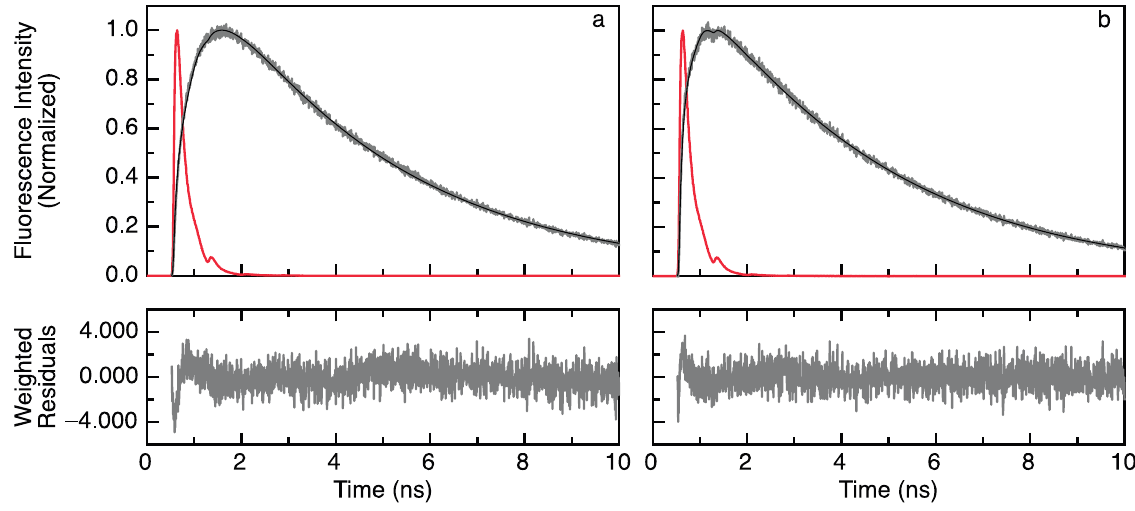
Figure 1. Fluorescence lifetimes with corresponding negative and positive amplitudes characterize the time-resolved fluorescence of the acceptor upon donor excitation. ( Top ) The time dependence of experimental (grey) and fitted (black) fluorescence intensity of apoflavodoxin labeled with A488 (donor) and A568 (acceptor) (see the Experimental Section for details on the theoretical background, protein labeling and data acquisition and analysis). The decay of reference compound erythrosine B has a fluorescence lifetime of 89 ps (red line); ( Bottom ) The weighted residuals between experimental and fitted curves (grey lines). ( a ) Acceptor fluorescence of folded, double-labeled apoflavodoxin in 0 M GuHCl. The rise time is 0.51 ns (confidence limits at the 0.67 confidence level are 0.50 and 0.53 ns); decay time is 3.85 ns (confidence limits at the 0.67 confidence level are 3.84 and 3.86 ns). The absolute value of the amplitude ratio | A − / A + | is 0.44. The fit quality criterion χ 2 is 1.226; and ( b ) Acceptor fluorescence of unfolded, double-labeled apoflavodoxin in 4.12 M GuHCl. The rise time is 1.57 ns (confidence limits at the 0.67 confidence level are 1.41 and 1.78 ns); decay time is 3.71 ns (confidence limits at the 0.67 confidence level are 3.67 and 3.73 ns). The absolute value of the amplitude ratio | A − / A + | is 0.134. The fit quality criterion χ 2 is